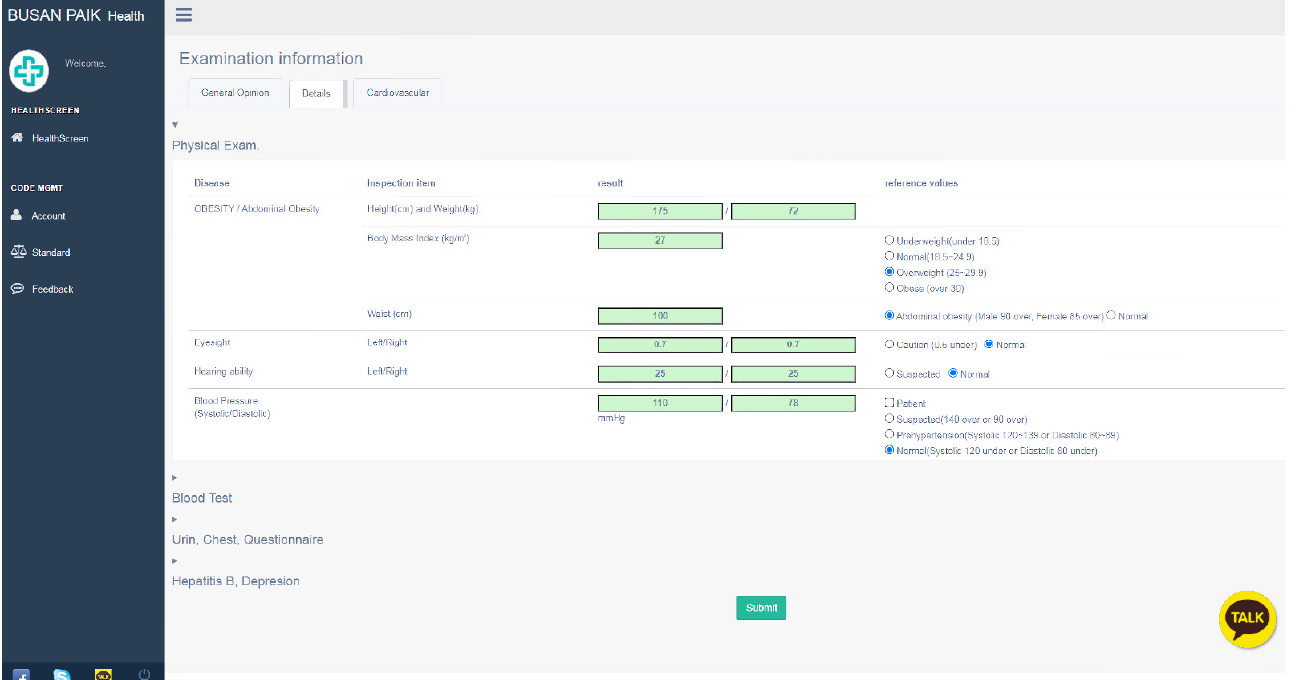
Figure 3. Web program to check the examination data and results in the chatbot